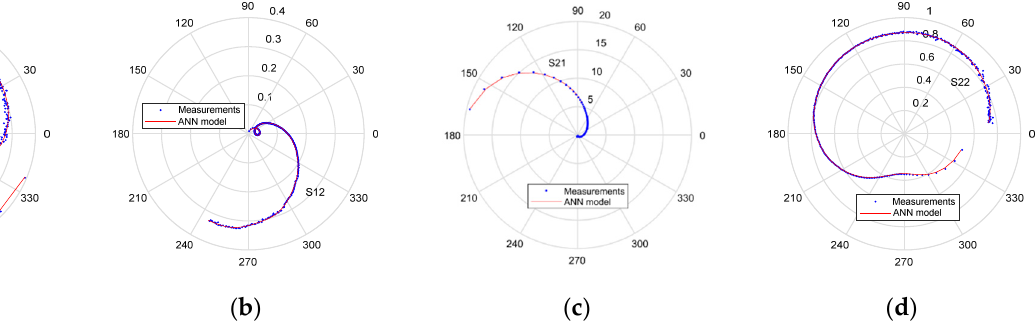
Figure 11. Measured (blue symbols) and ANN simulated (red lines) behavior of ( a ) S 11 , ( b ) S 12 , ( c ) S 21 , and ( d ) S 22 with the frequency range spanning from 200 MHz to 65 GHz for the DUT at V DS = 30 V, V GS = − 3.1 V, and T a = 90 °C.